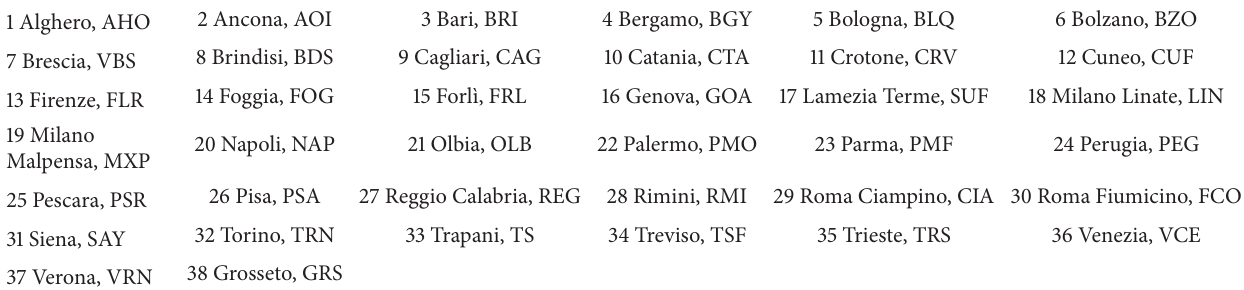
Table 1: Commercial airports in Italy (reference year: 2012, source: